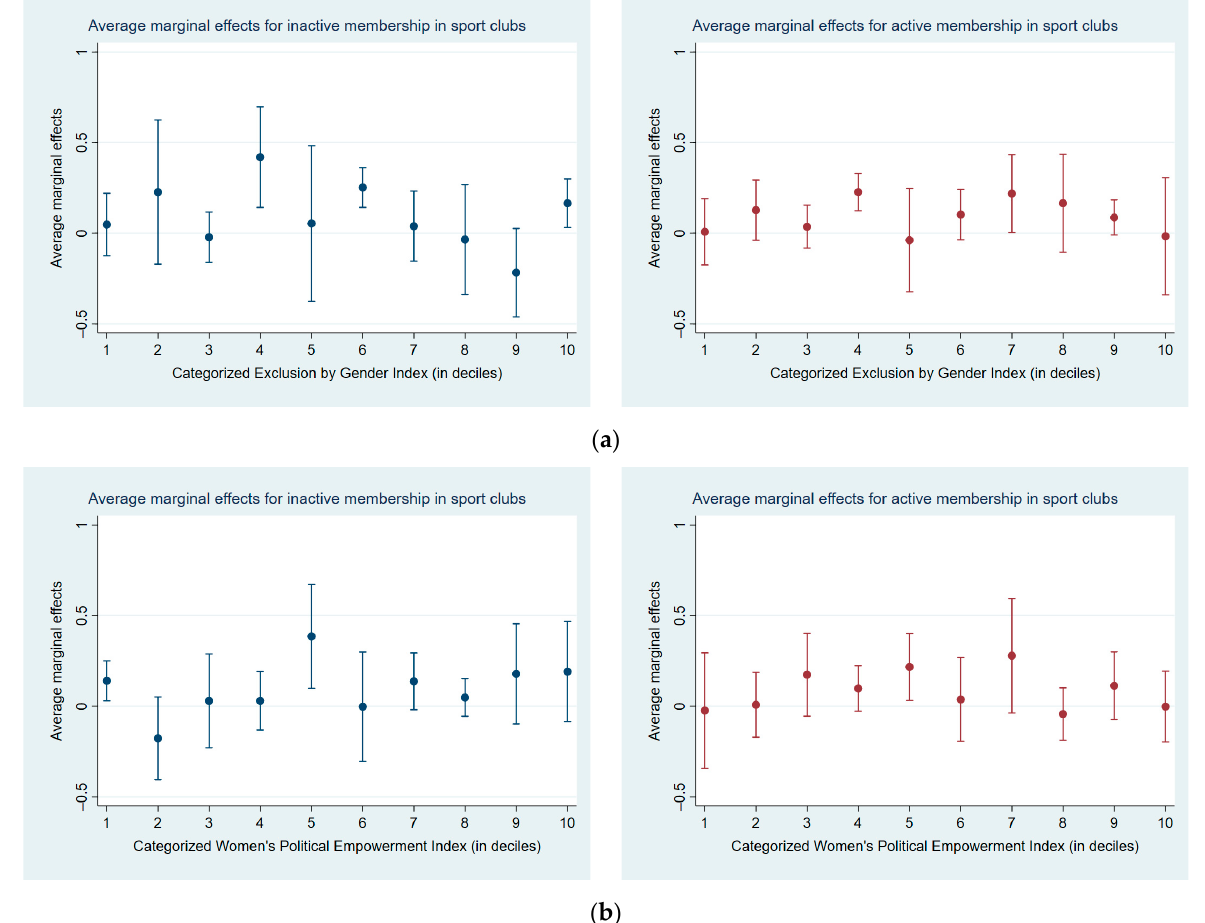
Figure 5. Average marginal effects for active and inactive membership in sports clubs ( a ) conditioned on the deciles of the Exclusion by Gender Index and ( b ) conditioned on the deciles of the Women’s Political Empowerment Index for the group of men. We included 95% confidence intervals using robust standard errors. Source: WVS-EVS data and V-Dem